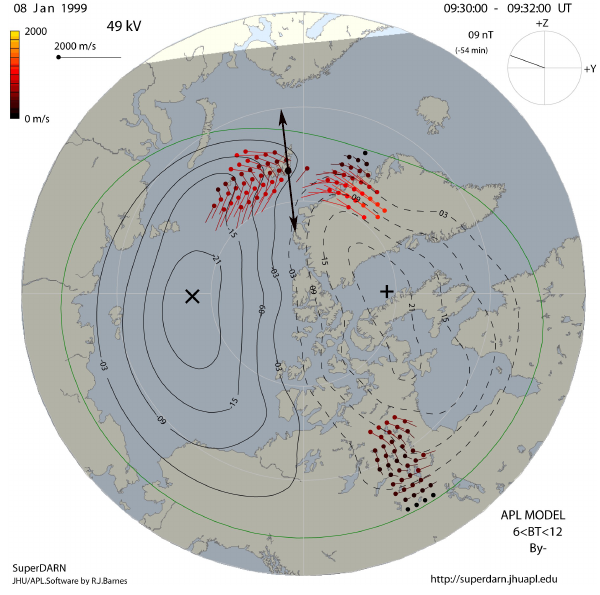
Fig. 21. SuperDARN convection data for 09:40–09:42UT. Same format as in Fig.